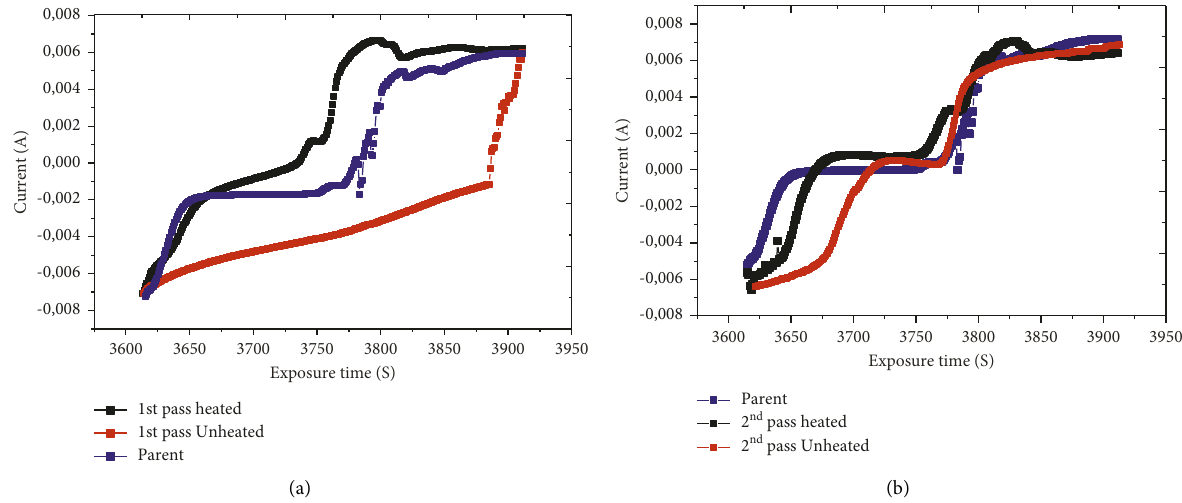
Figure 8: Time exposure vs. current density of the copper samples postheating, unheated, and parent samples (a) during the first pass and (b) during the second pass.